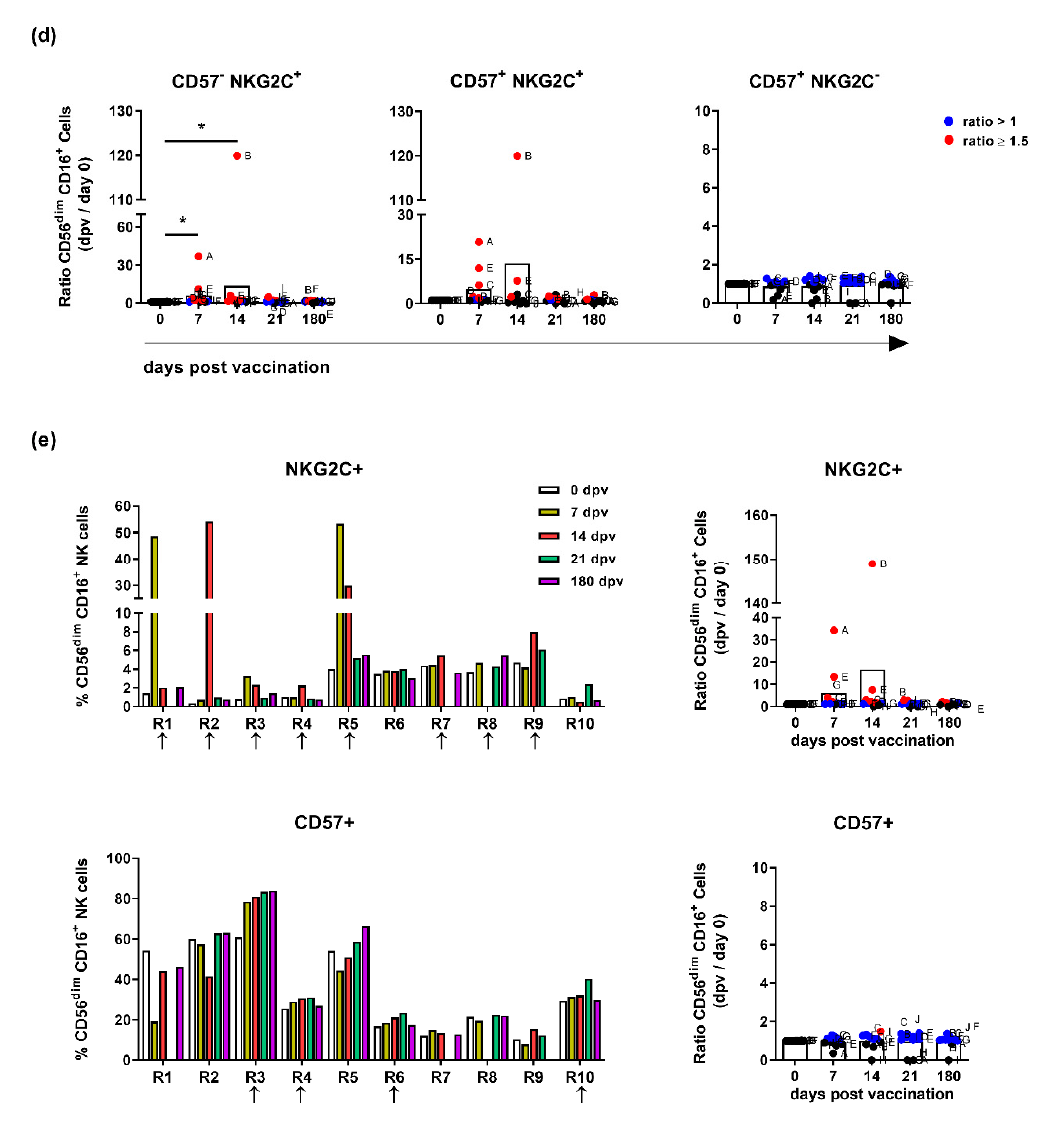
Figure 1. Influenza vaccination a ff ects the frequency of NKG2C-expressing natural killer (NK) cells. Peripheral blood mononuclear cells (PBMCs) isolated from vaccinated individuals prior to vaccination and at the indicated time points post-vaccination (dpv = days post-vaccination) were stained for the surface markers CD56, CD3, CD16, NKG2C and CD57. ( a ) Frequencies of total CD3 − CD56 + NK cells and ( b ) of CD3 − CD56b right , CD3 − CD56 dim and CD3 − CD56 dim CD16 + NK cell subpopulations. Diagrams show the connected column mean with 95% confidence interval. ( c ) Frequencies of NK cell populations characterized by the expression of CD57 and NKG2C. Columns represent individual data points. ( d ) CD57- and NKG2C-expressing CD56 dim CD16 + subpopulations depicted as the ratio of cell frequencies detected at the indicated time points post-vaccination and the frequencies detected prior vaccination (day 0). Diagrams are depicted as scatter plots with bars of individual assigned data points. ( e ) CD56 dim CD16 + NKG2C + and CD56 dim CD16 + CD57 + NK cells displayed as frequencies and as the ratio to the day before vaccination. Columns represent individual data points; diagrams are depicted as scatter plots with bars of individual assigned data points. Arrows indicate donors with vaccine-induced immunological changes. Asterisks denote significant values as calculated by unpaired and non-parametric Kruskal–Wallis test. * p ≤ 0.05. Letters in panels ( d , e ) indicate single responders.